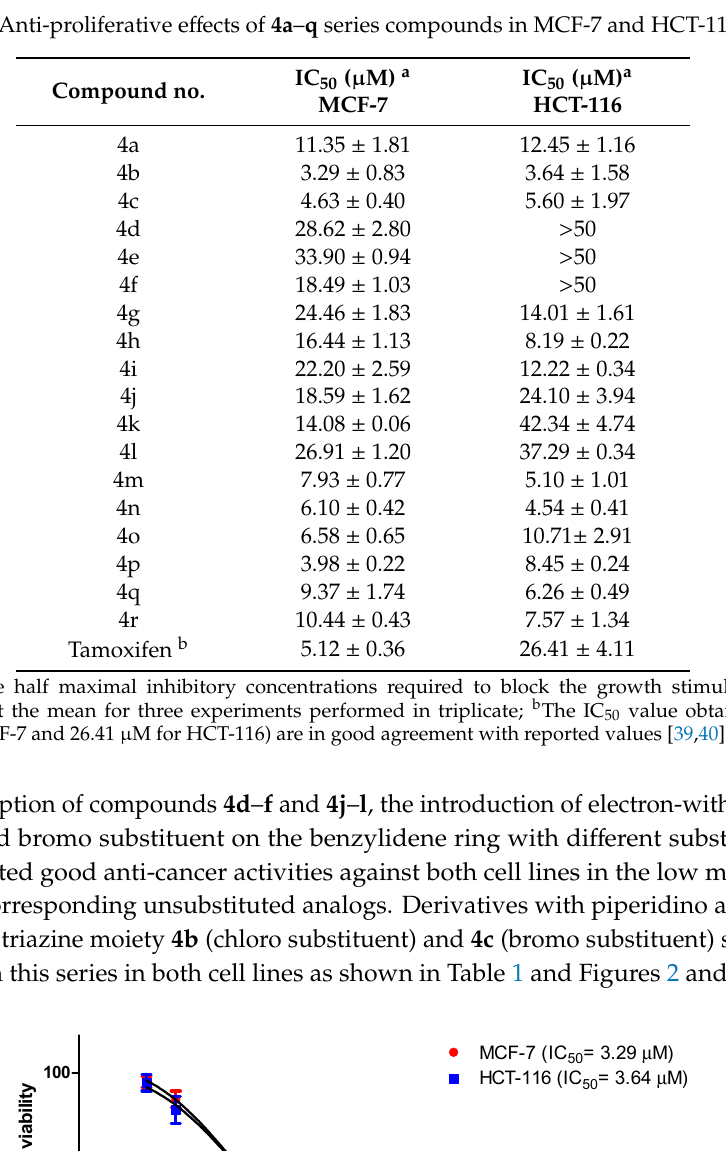
Figure 3. Anti-proliferative effect of 4c in MCF-7 and HCT-116 cells. Cells were grown in 96-well plates and treated with 4c at 0.1 µM to 100 µM for 72 h. Cell viability was expressed as a percentage of vehicle control [ethanol 0.1% (v/v)] treated cells. The values represent the mean ± S.E.M. for three independent experiments performed in triplicate. Based on the obtained results, we examined apoptosis in MCF-7 cells after treatment with the most active compound 4b . The percentage of early and late apoptotic cells was determined by double staining with Annexin V and PI via flow cytometry. Positioning of quadrants on dot plots was designated, and living cells (Annexin V − /PI − ), early apoptotic cells (Annexin V+/PI − ), late apoptotic cells (Annexin V+/PI+) and necrotic cells (Annexin V − /PI+) were identi fi ed. The data shown in Figure 4 prove that the MCF-7 cells were incubated with 4b at a concentration of 6 µM for 24 h decreased the population of viable cells and increasing the percentage of apoptotic cells. The percentage of early and late apoptotic cells together of 4b increased after 24 h to 21.81% and 6.93%, respectively at 6 µM when compared to the control cells (2.23%) as shown in Figure 4. These results show the ability of 4b to induce apoptosis in cancer cells and may deliver an excellent scaffold for the development of anti-cancer drug candidates.